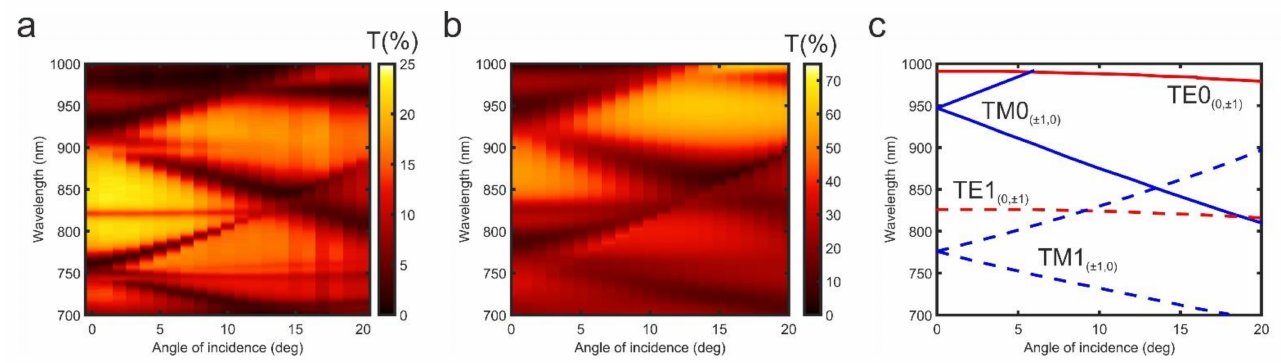
Figure 2. Angle resolved transmission spectra of the sample under p-polarized light excitation. ( a ) Experimental, ( b ) numerical, ( c ) calculated modes